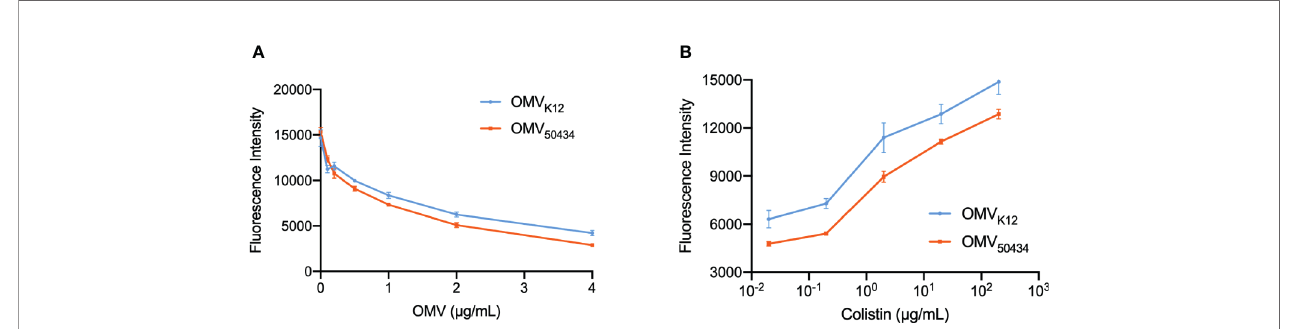
FIGURE 3 | Titration of OMVs against BC (A) and displacement of OMV-bound BC by colistin (B) . (A) BCs (4 m M) were titrated by OMVs isolated from E. coli K12 or E. coli 50434 ( E. coli K12 with mcr-1 ) ranging from 0.1 to 4 m g/ml protein concentration. (B) Colistin (0.02 – 200 m g/ml) was successively added to the BC : OMV complex. Excitation: 580 nm; Emission: 620 nm. n =